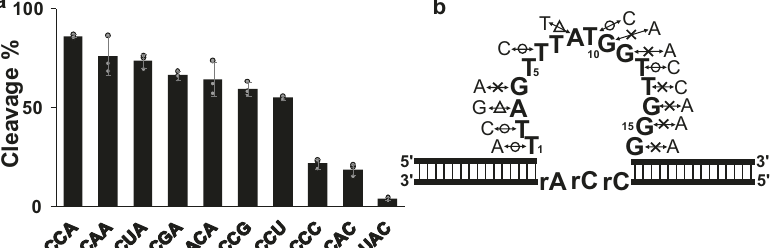
Fig. 3 A point mutation analysis of ZincDz2. a A point mutation analysis within the core catalytic region of ZincDz2. The error bars represent the standard deviation (SD) from the average of three independent experiments. b An annotated illustration of ZincDz2 mutants. The cleavage activity of each substitution, relative to the ZincDz2, is indicated: circle, equivalent; triangle, moderately reduced; cross, drastically